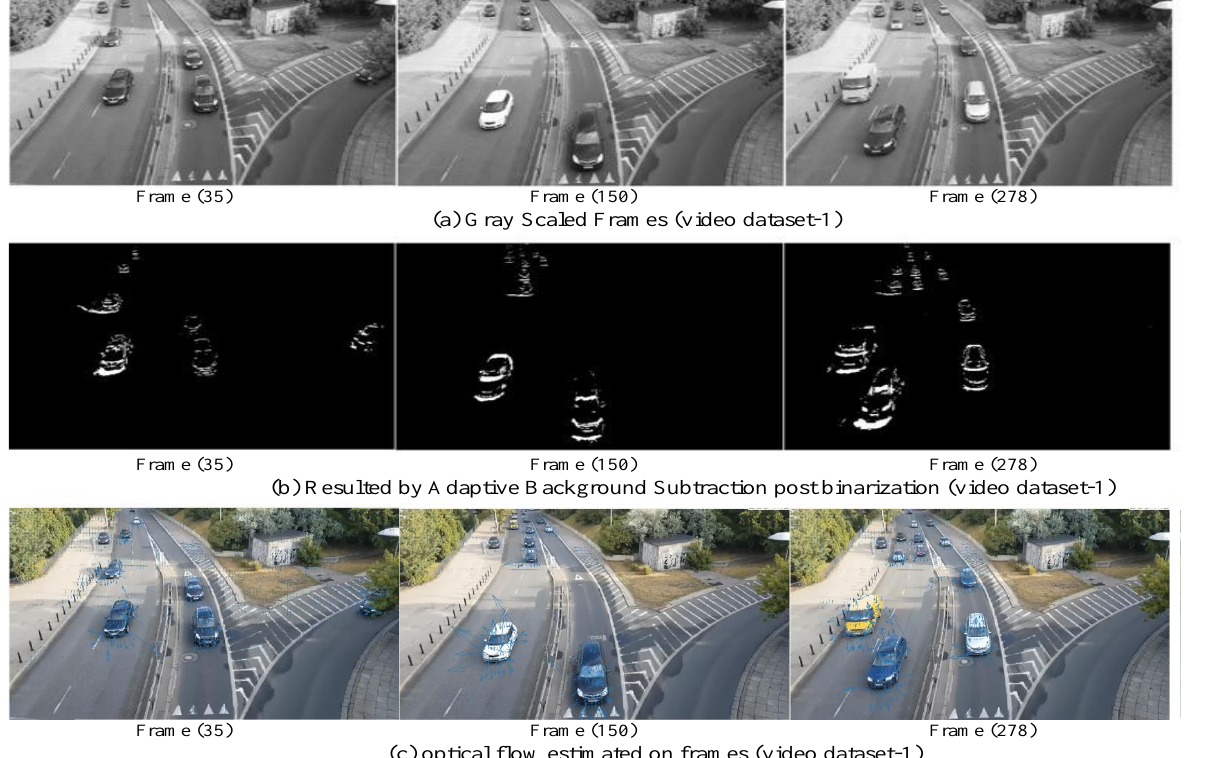
Figure 5. Activity map and pixel sensitivity maps of video dataset 1 by different approaches: ( A ) by Pan et al. in [12]; ( B ) by Mehboob et al. in [13]; ( C ) by Indu, S. in [14]; ( D ) our proposed framework. B.